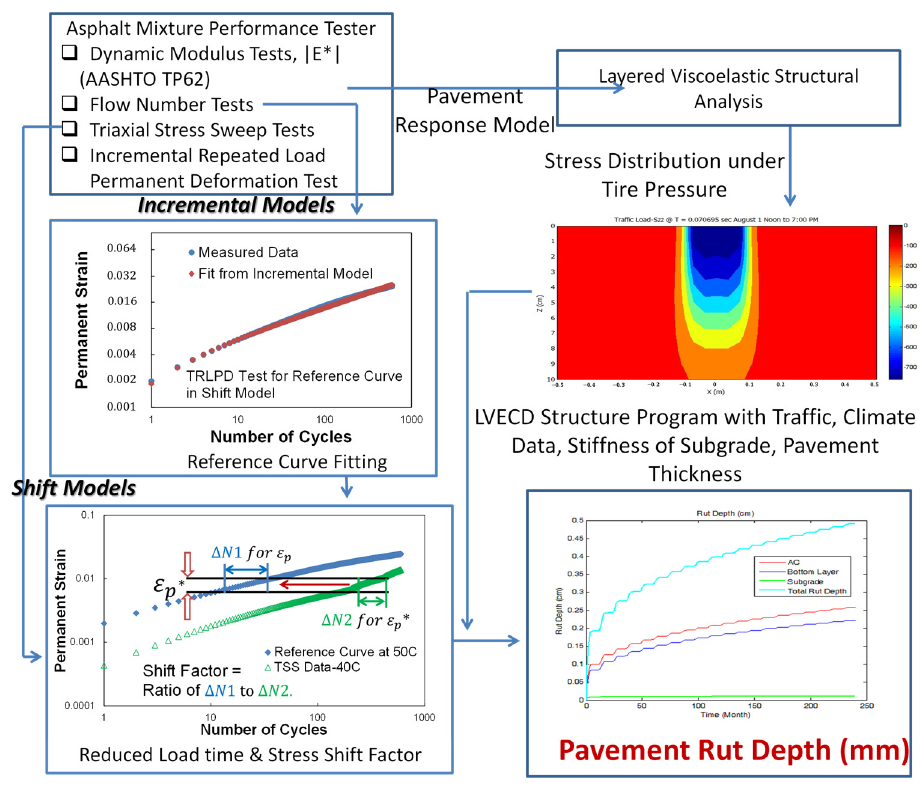
Polymers 2023 , 15 , x FOR PEER REVIEW Figure 6. Mechanistic rut depth prediction method. Figure 6. Mechanistic rut depth prediction method.